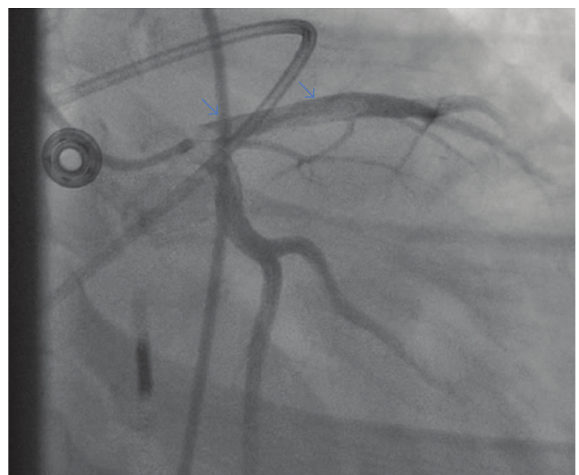
Figure 2: Coronary angiogram demonstrating a large filling defect in the proximal and mid portion of the left anterior descending (LAD) artery with distal TIMI 0 flow.